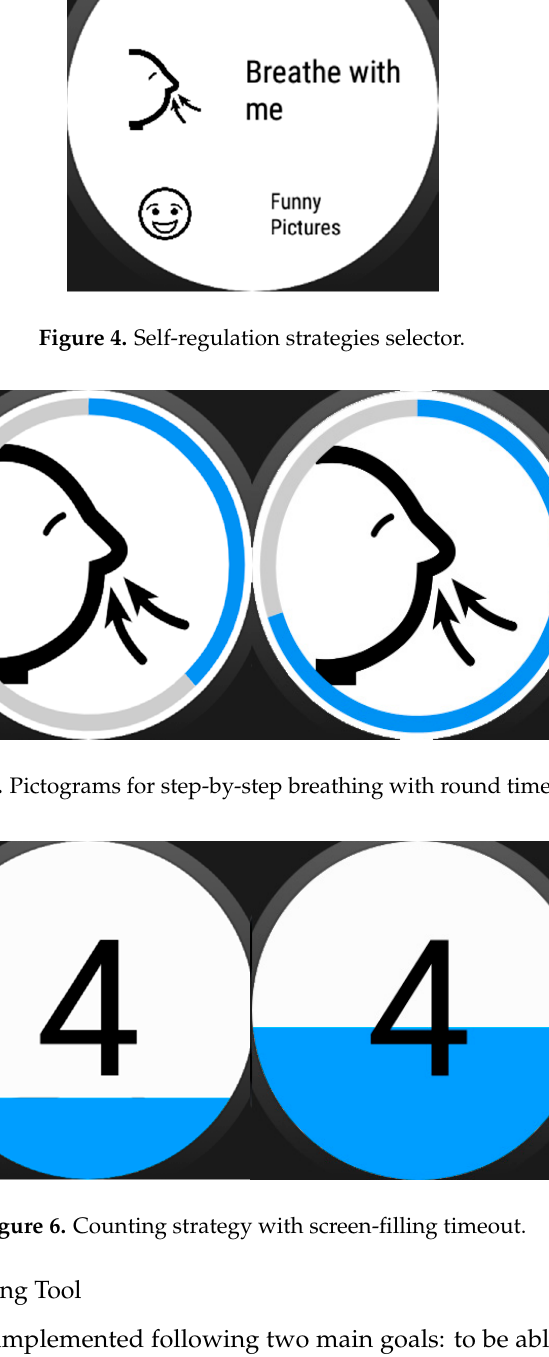
Figure 6. Counting strategy with screen ‐ filling timeout.